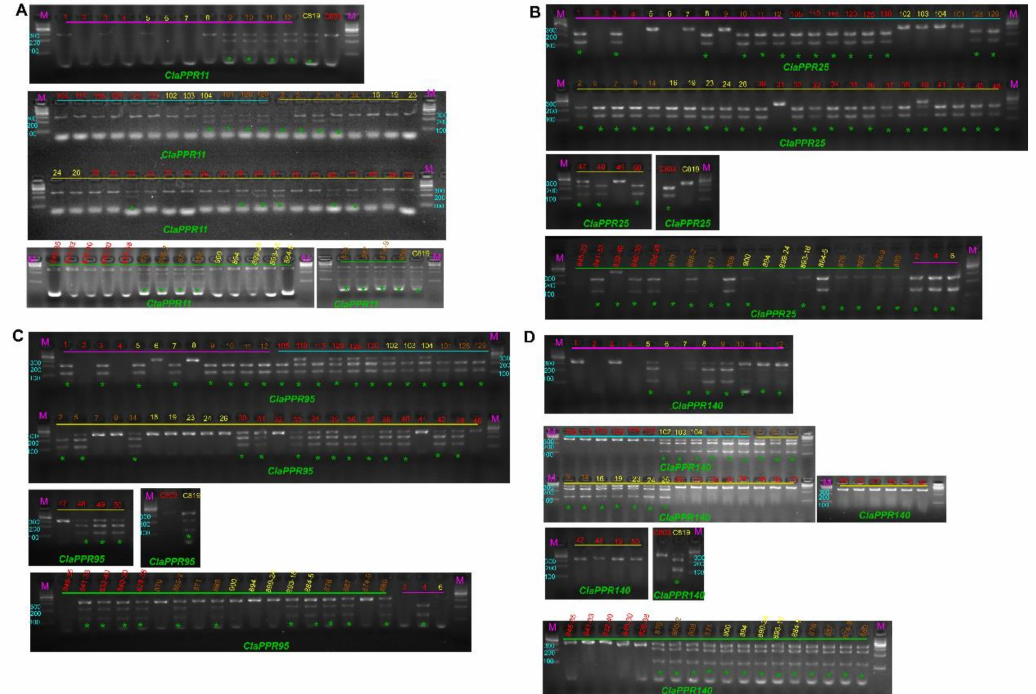
Figure 6. Gel pictures for the validated cleaved amplified polymorphic sequence (CAPS) markers based on single-nucleotide polymorphisms (SNPs) in PPR genes. The name of validated CAPS markers such as ClaPPR11 ( A ), ClaPPR25 ( B ), ClaPPR95 ( C ), and ClaPPR140 ( D ) are shown below their corresponding gel pictures. Numbers in lanes underlined with di ff erent colors indicates the DNA sample names of the 70 lines, same as those listed in Table S7. M represents a 100 bp ladder. A “ green asterisk ” represents the enzyme-cleavage of the DNA samples. DNA samples of C803 (red-flesh) and C819 (yellow-flesh) were used as control (Table S7) during the restriction digestion of PCR